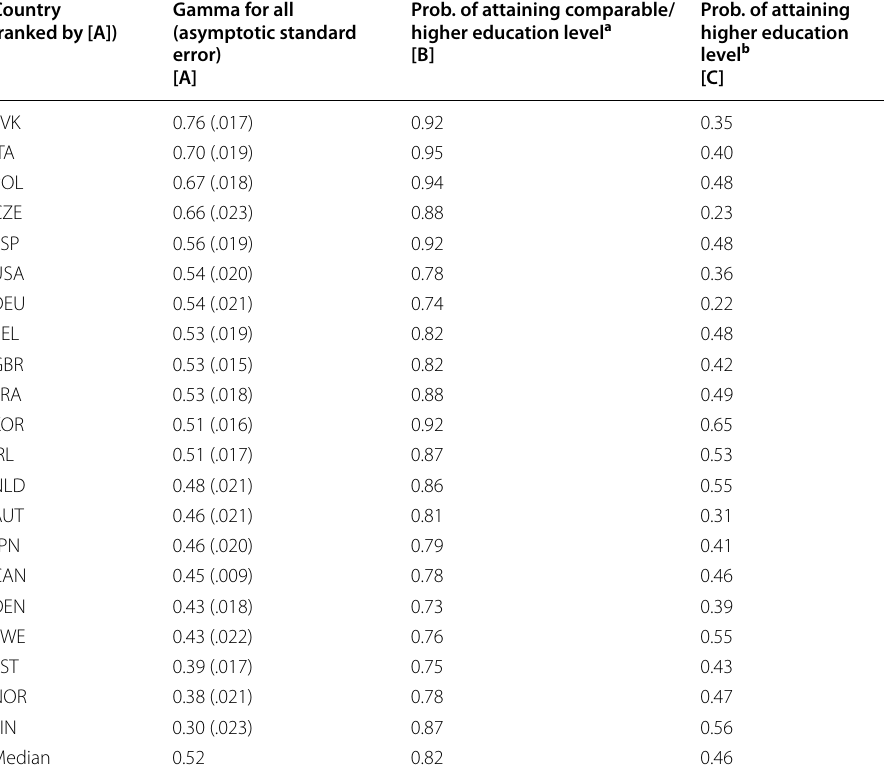
Table 2 Association between Parental Education and Educational Attainment (Gamma coefficients), Probability of Attaining Comparable/Higher Education Level than Parents and Probability of Attaining Higher Education Level than